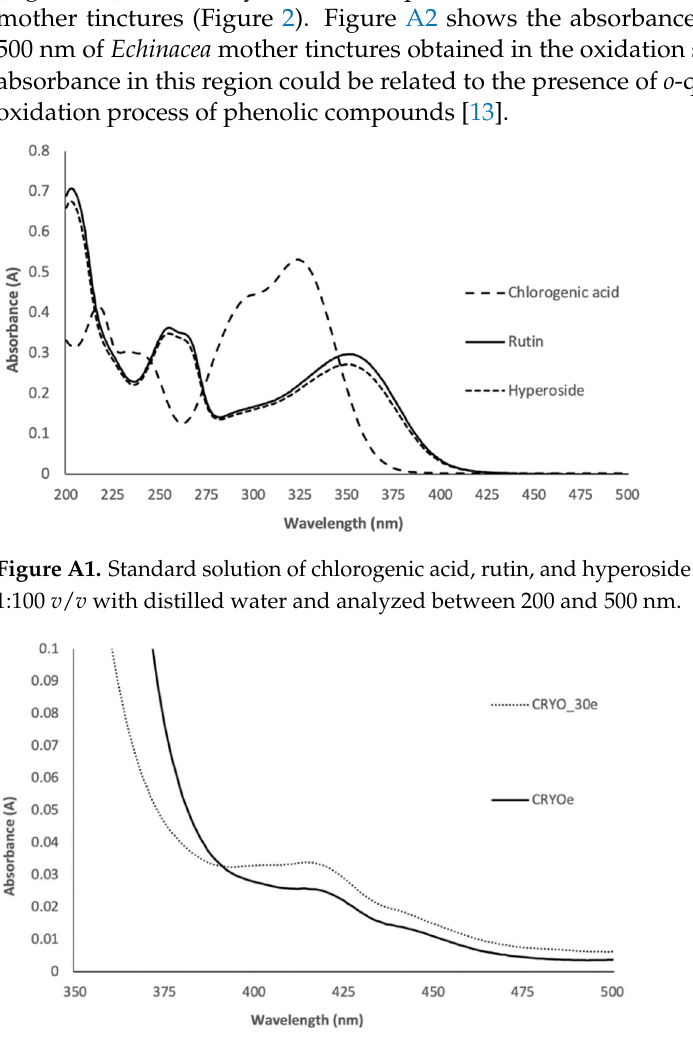
Figure A2. Spectrophotometric UV–Vis analysis of mother tinctures obtained in the oxidation stress test of Echinacea purpurea . UV–Vis spectra show the comparison between the cryoground “oxidation-free” reference (CRYO) and cryoground + 30 min air-exposed (CRYO_30) extract. The figure is a scale zoom of Figure 3A to underline the increase in absorbance in the wavelength region between 350 and 500 nm typical of the o -quinone moiety.